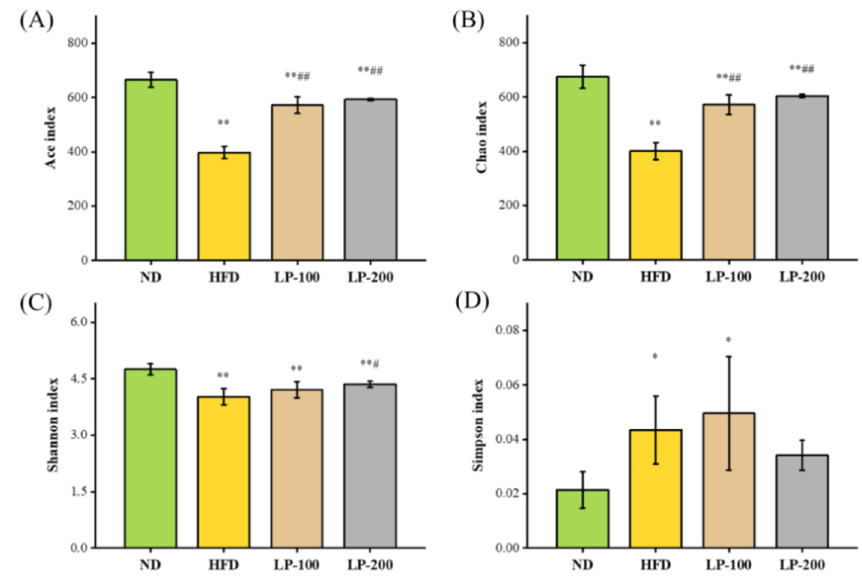
Figure 5. Comparison of the α -diversity index of the mice’s gut flora for each group ( A ) Chao index, ( B ) Ace index, ( C ) Shannon index, and ( D ) Simpson index. * p < 0.05, ** p < 0.01 compared with ND; # p < 0.05, ## p < 0.01 compared with HFD.